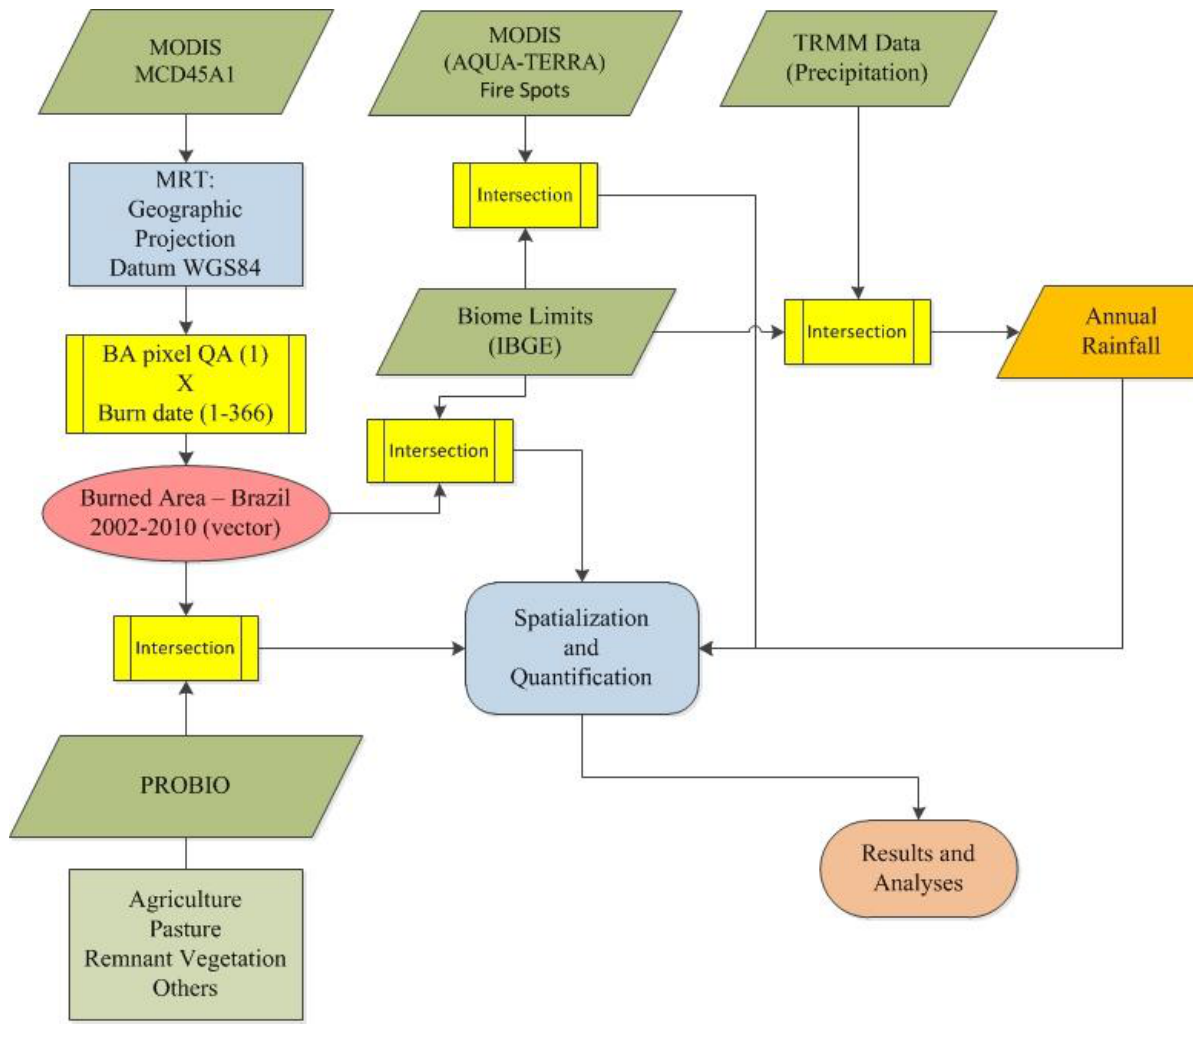
Figure 2. Schematic flowchart depicting the main steps and approaches followed in this